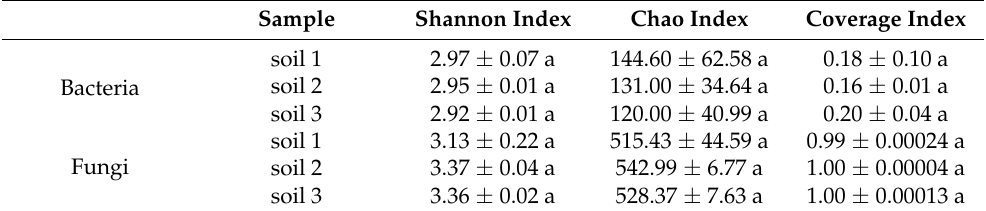
Table 1. Species diversity (Shannon index), richness (Chao index), and coverage (Coverage index) soil samples for OTUs constructed at 0.03 dissimilarity for bacterial and fungal